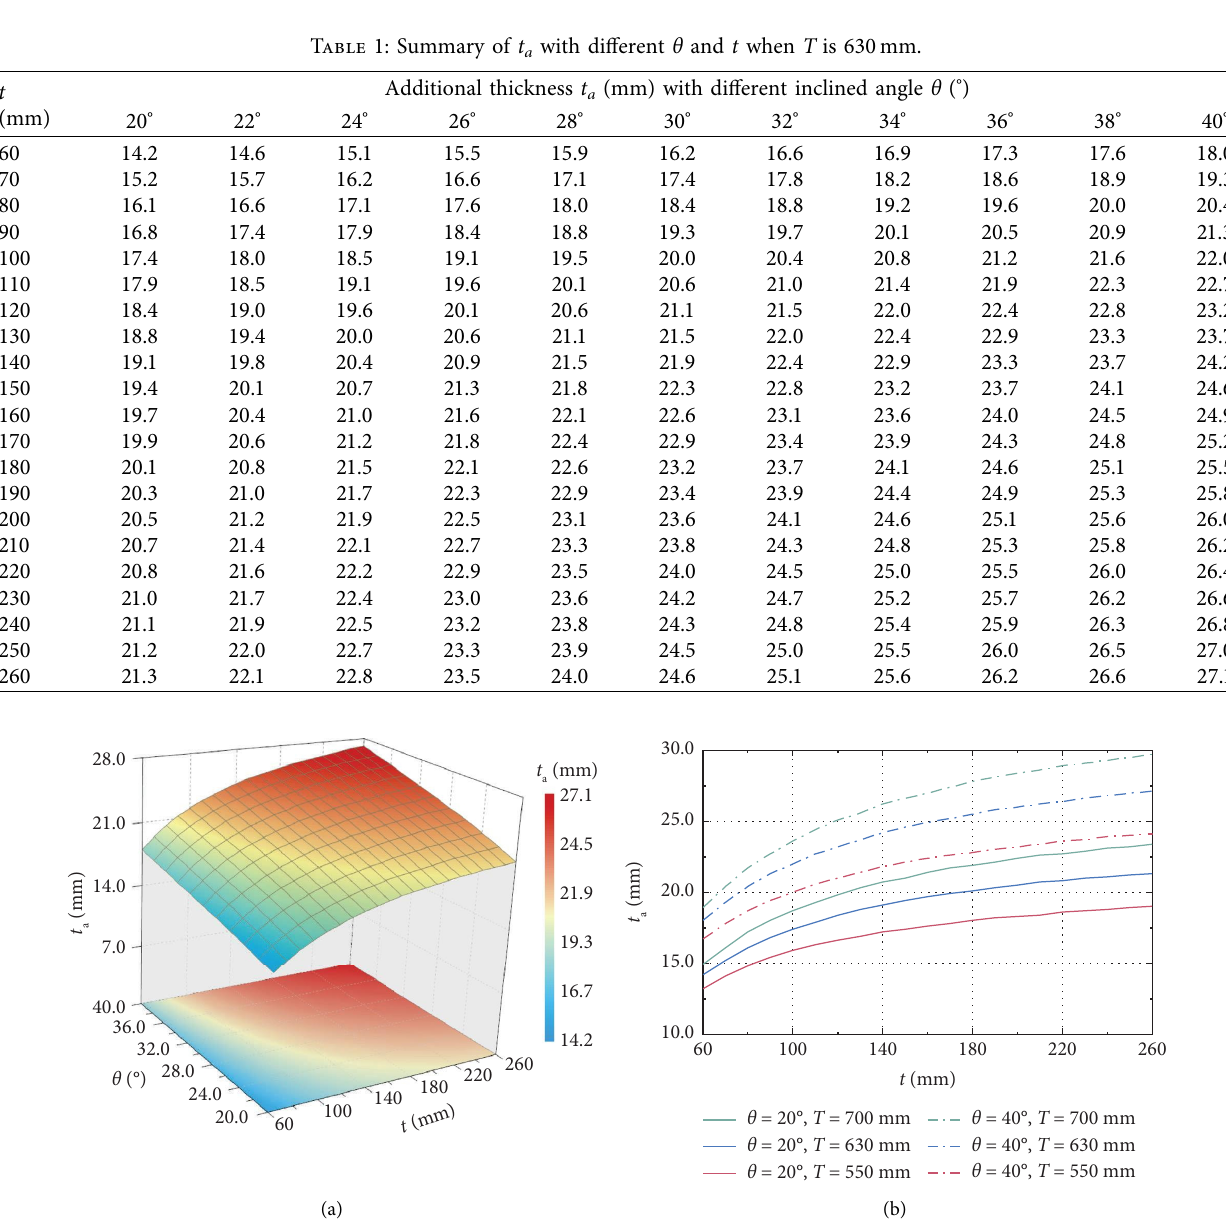
Figure 3: Te relationship among t a , T , θ , and t . (a) Te curved surface diagram of t a varying with θ and t when T is 630mm. (b) Curves of t a varying with t when θ � 20 and 40 ° and T � 550, 630, and 700mm.